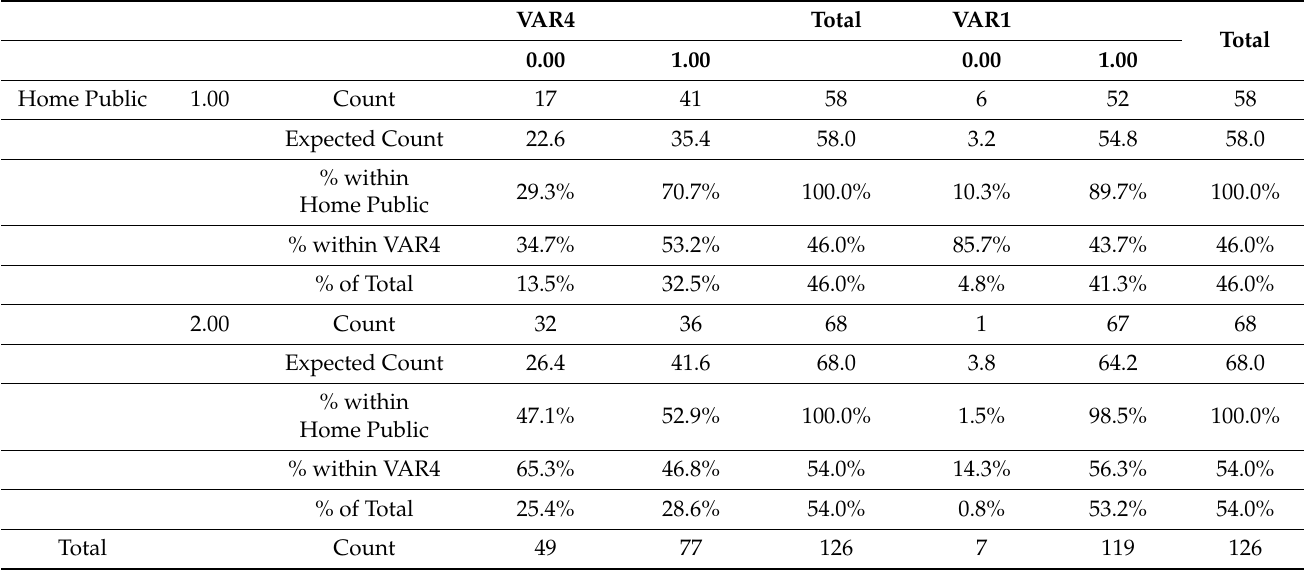
Table 7. The difference between individuals who meet a friend in a public spot, such as a park, caf é or bar or at their home against variables 4 and 1.